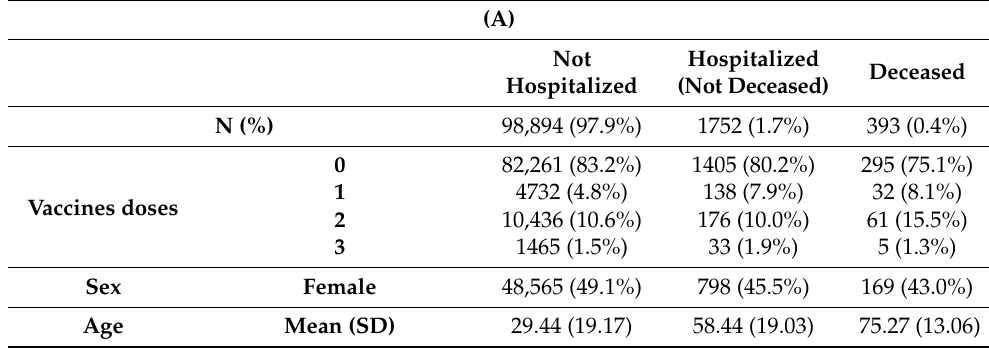
Table 1. ( A ) Demographic and clinical characteristics of the study population. ( B ) Clinical character- istics of the study population after missing variables